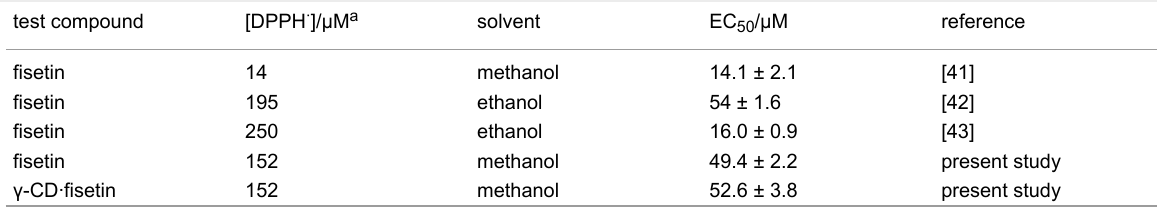
Table 2: Comparison of the DPPH · scavenging activities of pure fisetin and the γ -CD·fisetin inclusion compound obtained in the present study with the literature results reported for fisetin (at various concentrations of DPPH · ). test compound